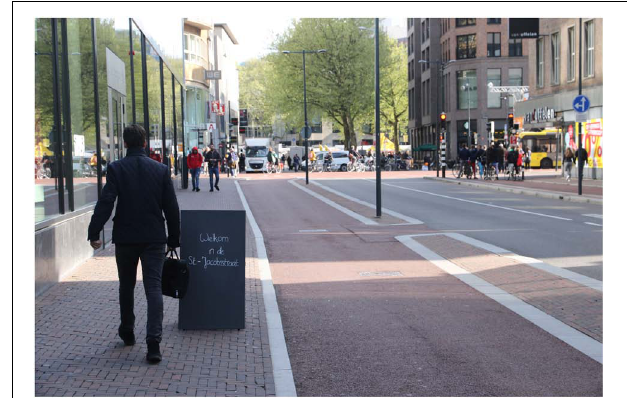
FIGURE 1 | The signboard reads “Welcome to St.-Jacobsstreet” (in Dutch: “Welkom in de St.-Jacobsstraat”). One observer was positioned on the pavement across the road (not visible in the picture) while the other was located adjacent to the first lamp post visible in the